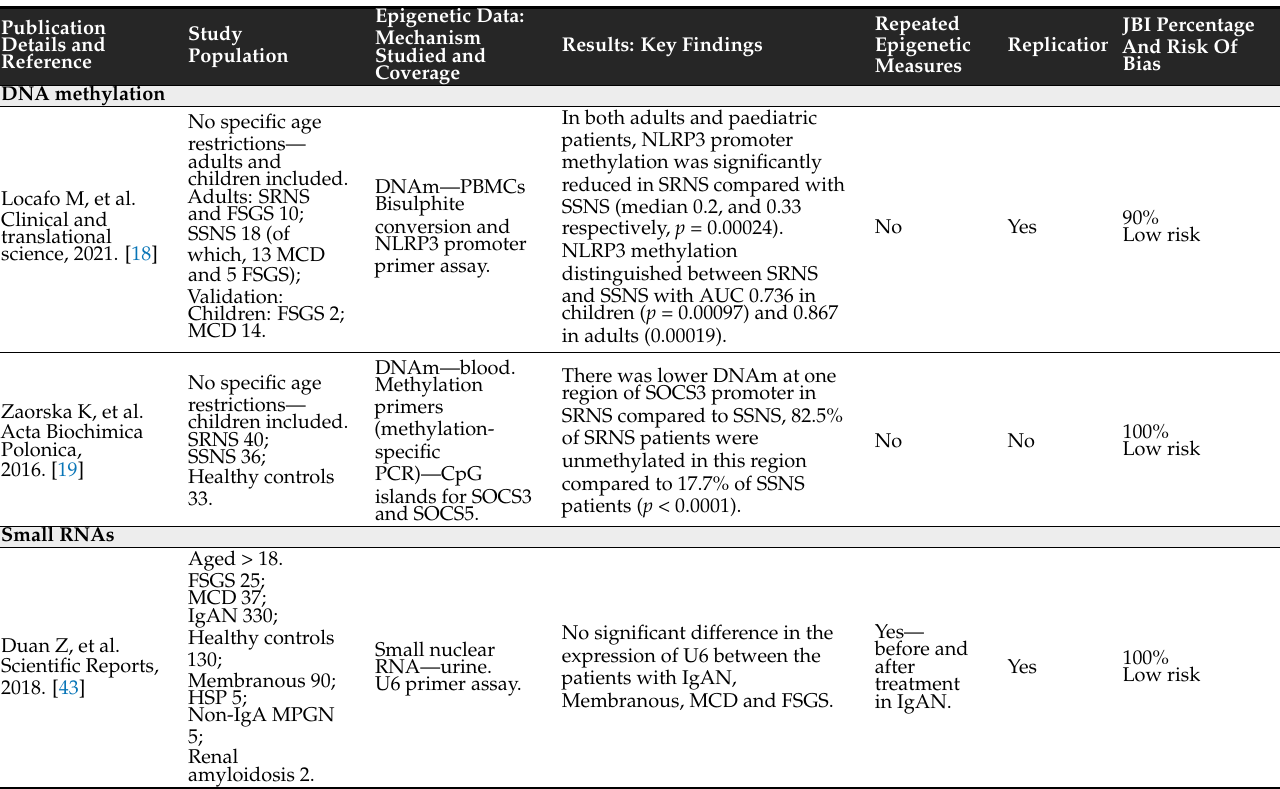
Table 3. Summary of the higher quality DNA methylation and small RNA